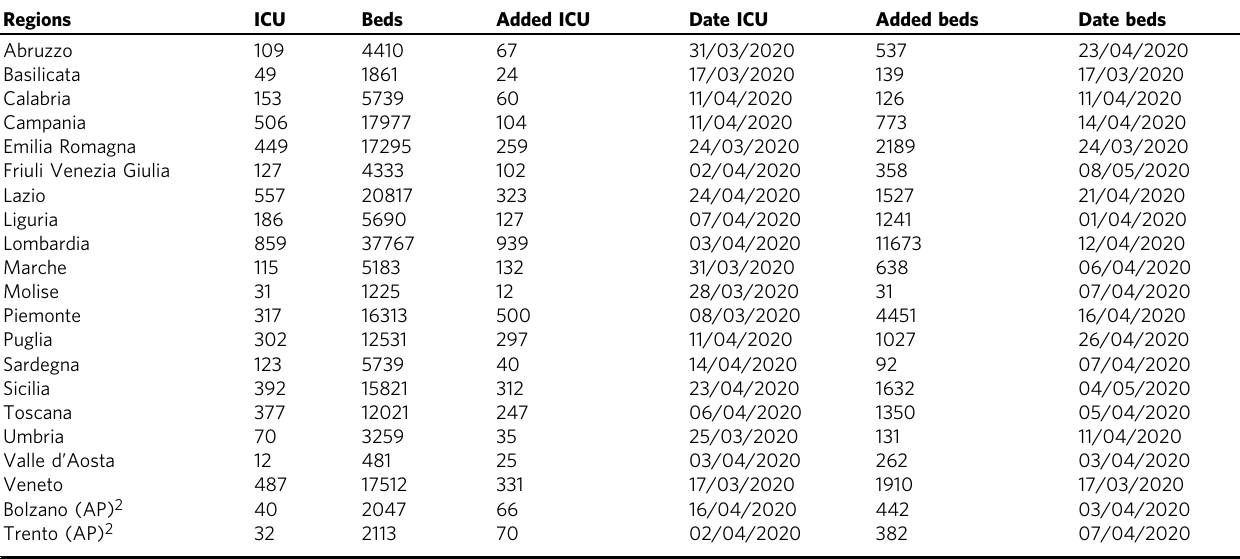
Table 3 Hospital bed and ICU capacity before and in the course of the pandemic 41,771,2 .